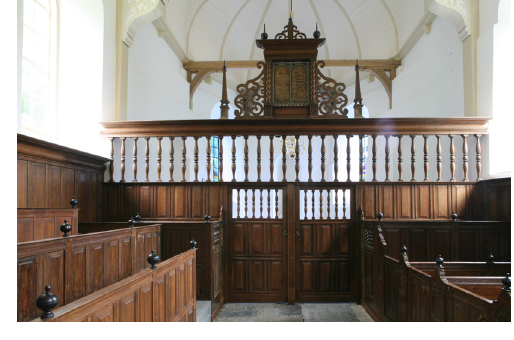
FIgure 17 Ten Commandments panel, Kimswerd, 1695, photo archive Regnerus